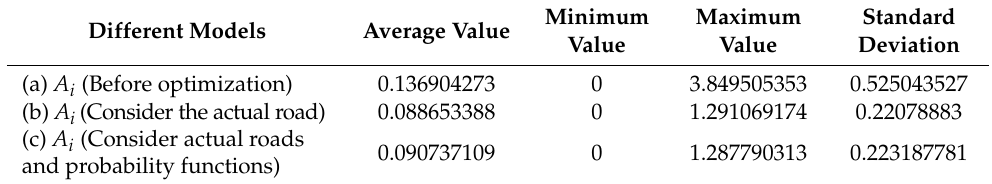
Table 1. Comparison of different models.